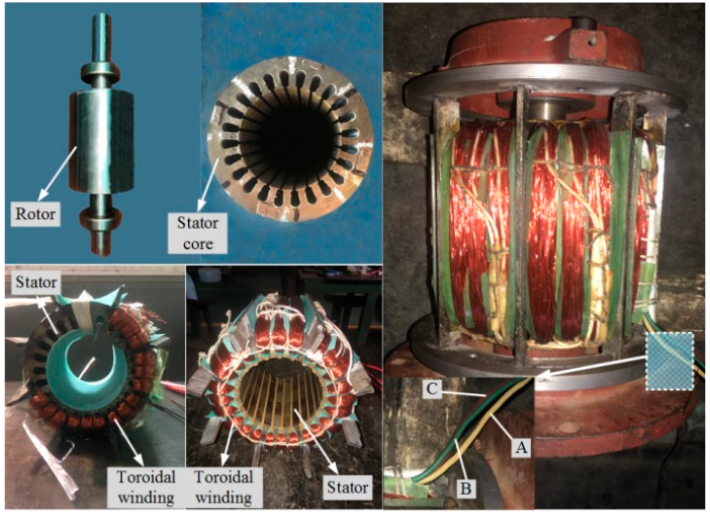
Figure 12. Prototype processing.